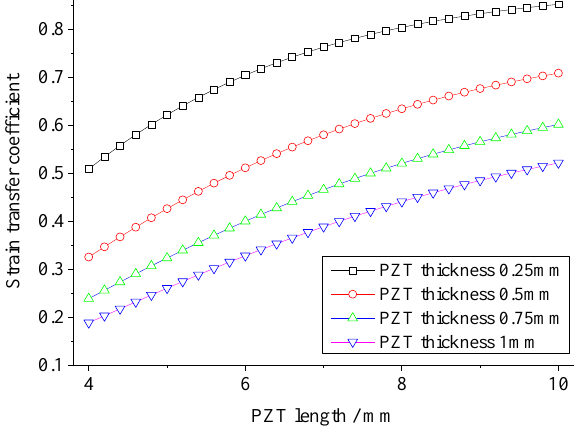
Figure 9. The strain transfer coefficient versus the PZT length in the theoretical model.